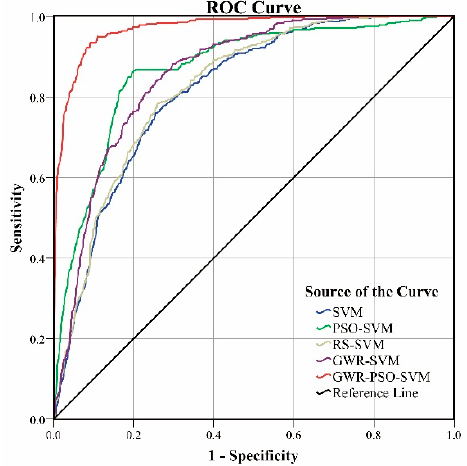
Figure 17. The ROC curve of all the prediction models.